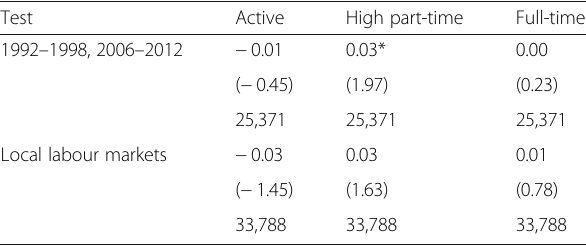
Table 8 Difference-in-differences estimates of the impact of the reform on maternal employment using alternative controls Test Active High part-time